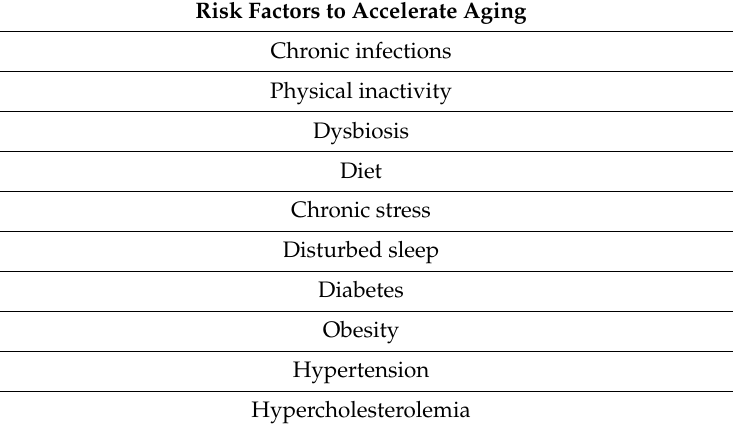
Table 1. List of risk factors to accelerate aging and neurodegenerative disorders like Alzheimer’s disease (AD). Several of these factors have been indicated [6,7] and some of them, like diabetes, obesity or hypertension, are risk factors for cardiovascular diseases [8]. On the other hand, chronic stress could be a main and earlier risk factor to accelerate aging